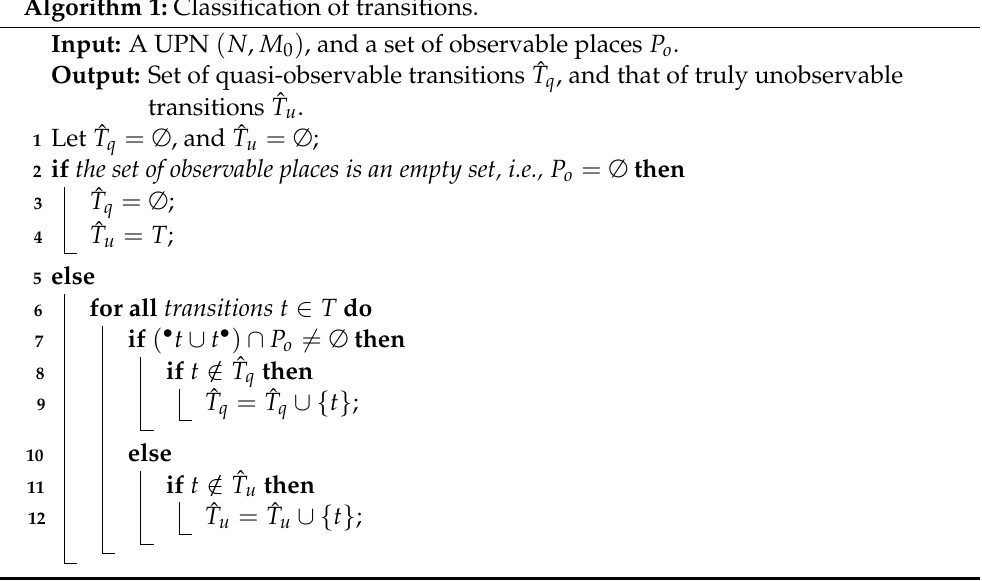
Algorithm 1: Classification of